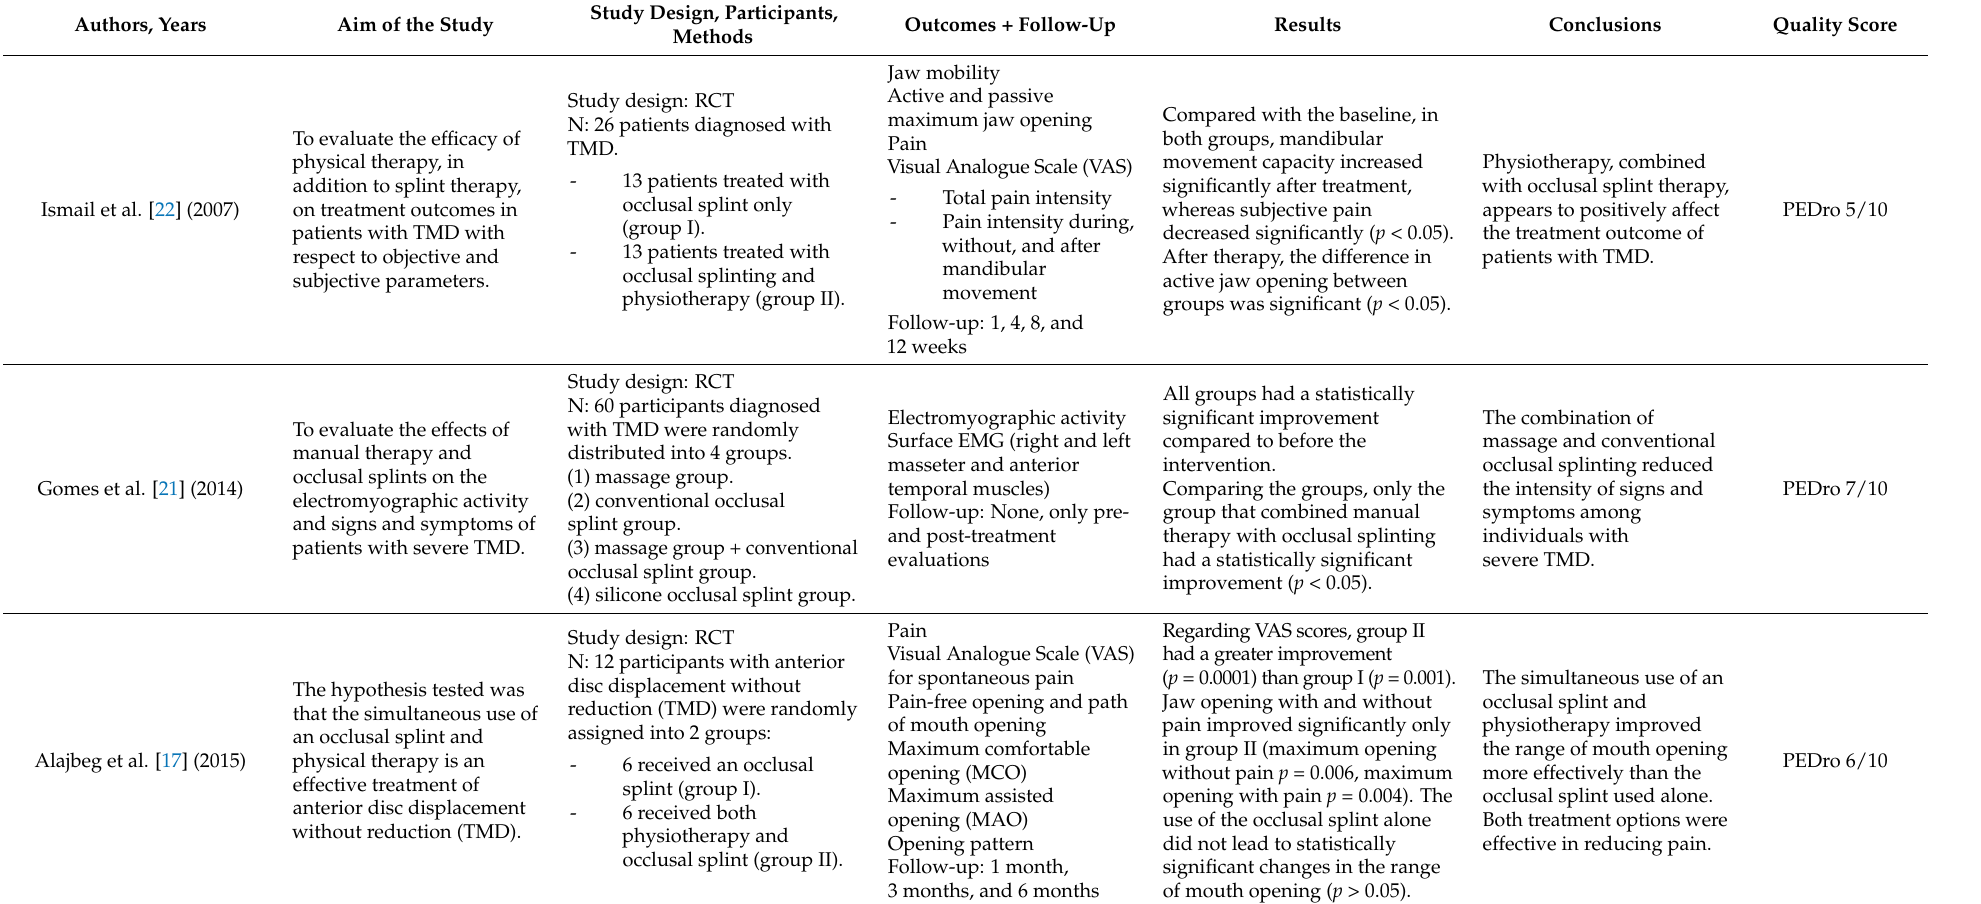
Table 1. Characteristics of included